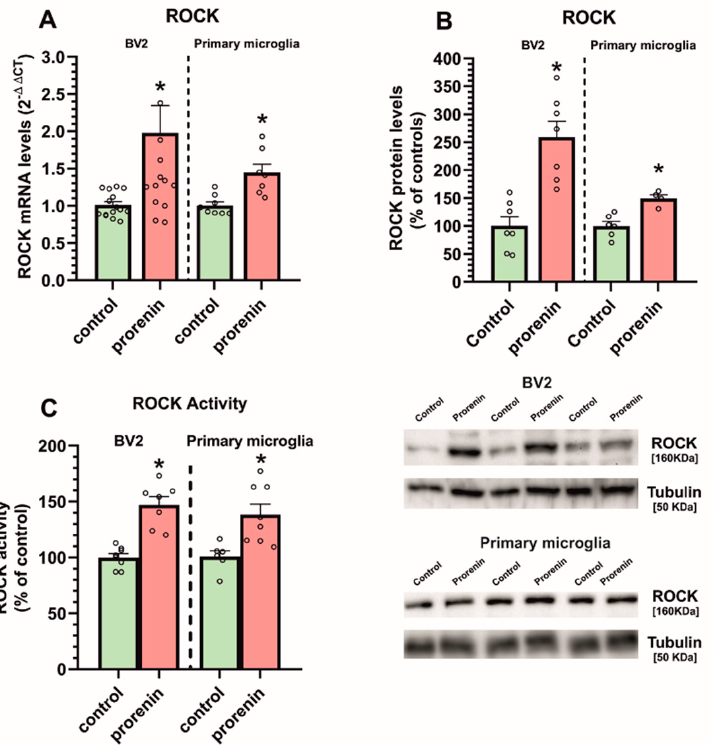
Figure 5. ROCK mRNA and protein expression ( A , B ) and ROCK activity ( C ) and in BV2 and primary microglia treated or untreated (control) with recombinant prorenin (5 nM) in the presence of losartan (100 nM). The mRNA expression was determined relative to the housekeeping transcripts ( β -Actin). For mRNA, the comparative cycle threshold values method (2 − ∆∆ Ct ) was used. Data are mean ± SEMs. * p < 0.05 relative to the corresponding control (Student’s t -test). ROCK, Rho ‐ kinase.